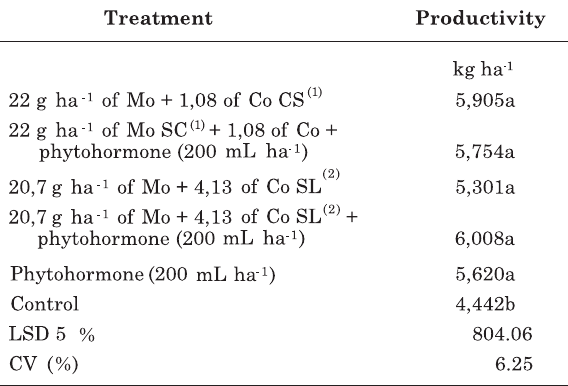
Table 1. Mean grain yield of soybean treated with